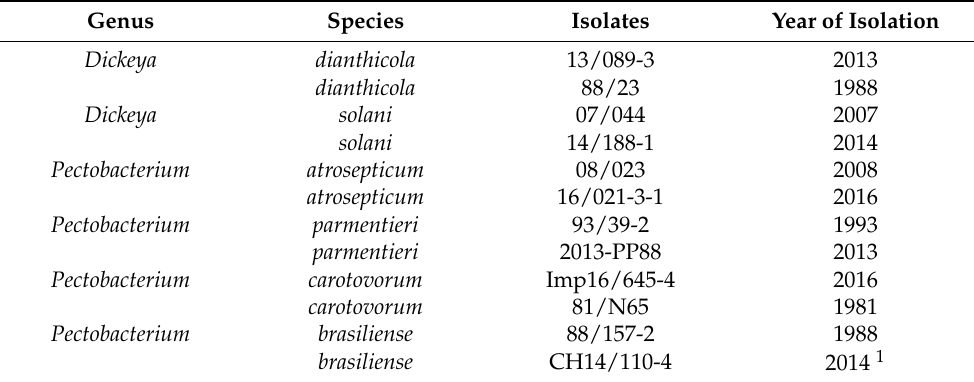
Table 1. Bacterial isolates used in this study, all from the Swiss Agroscope collection. Genus Species Isolates Year of Isolation Dickeya